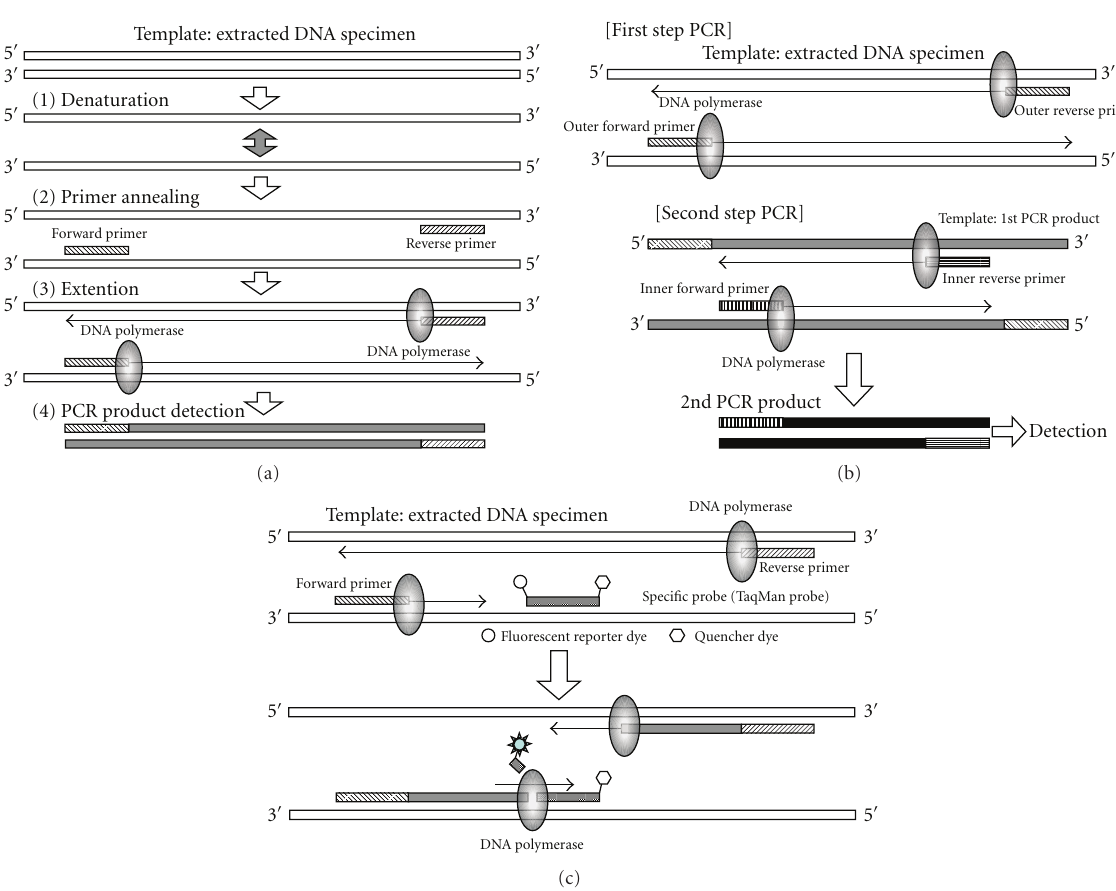
Figure 1: Schemata of the principles of polymerase chain reaction (PCR) assay techniques. (a) A schema indicating the basic principle of PCR assay. (b) A schema indicating the principle of nested PCR assay. (c) A schema indicating the principle of real-time (TapMan) PCR